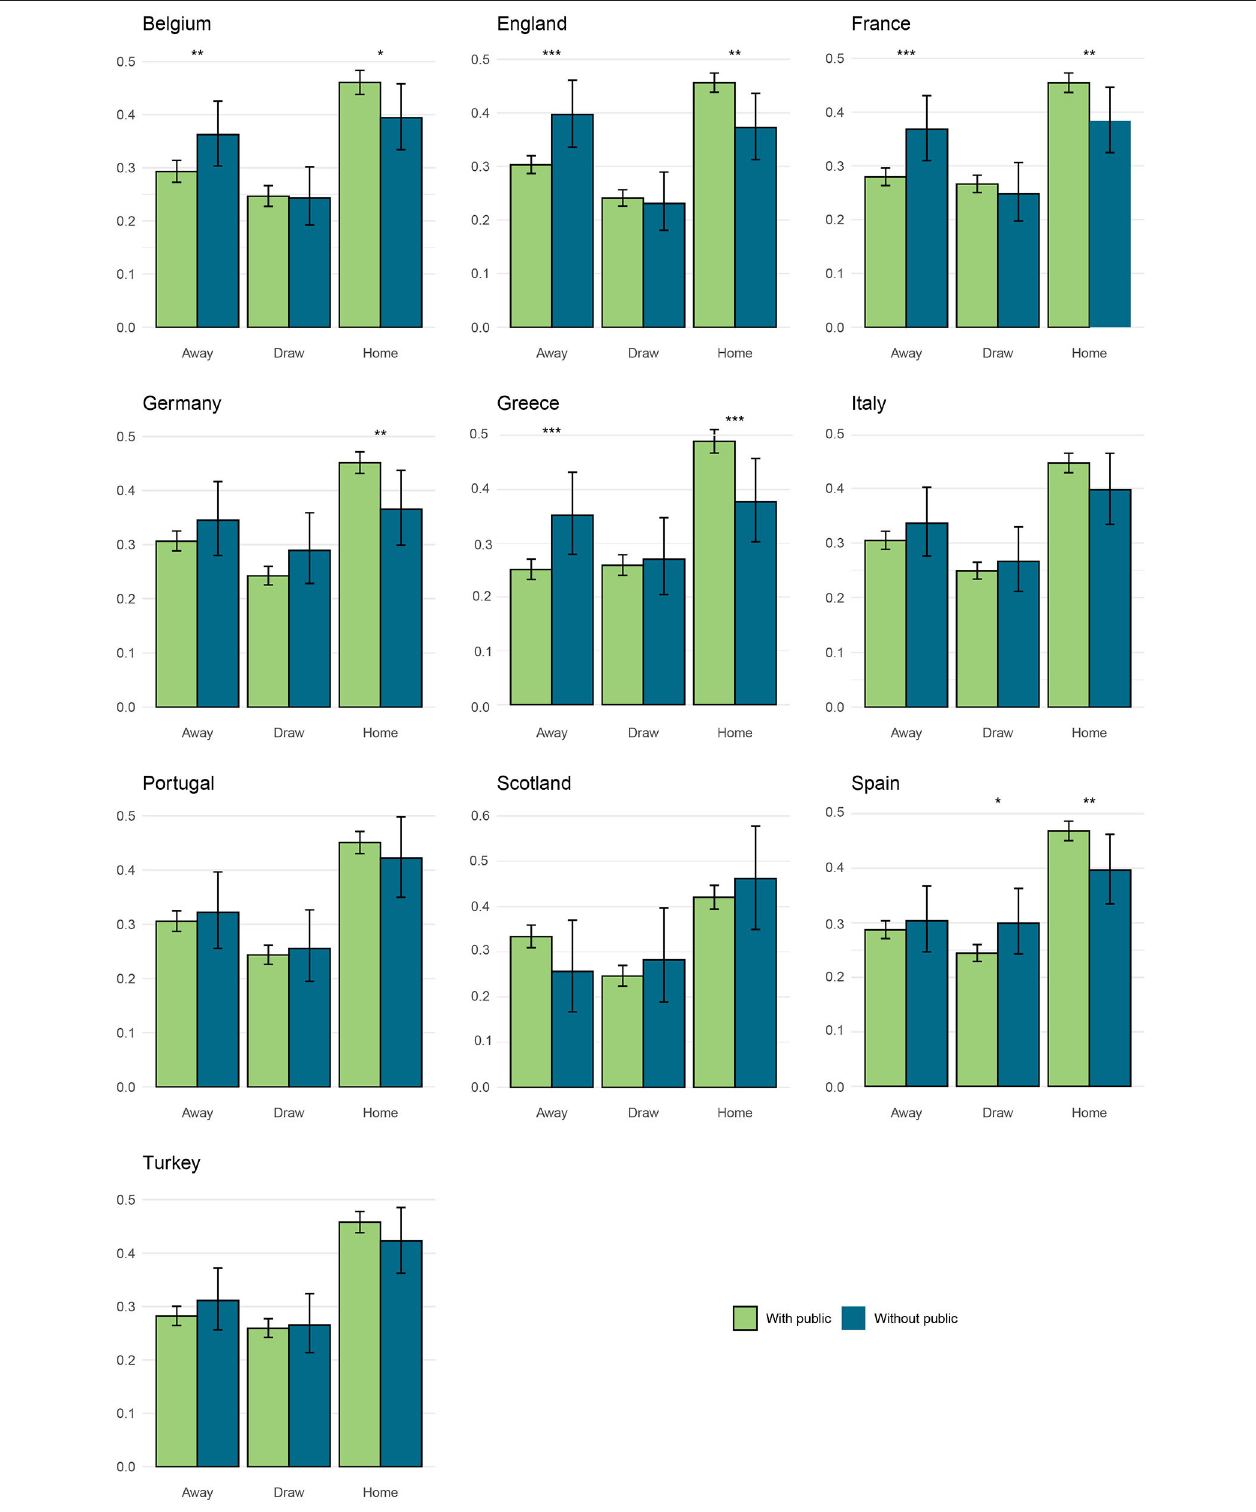
FIGURE 2 | Proportion of matches won at home, away, and drawn in European soccer first division championship with and without supporters. Significance thresholds were set at α = {0.1, 0.05, 0.01} (respectively *, **, ***).